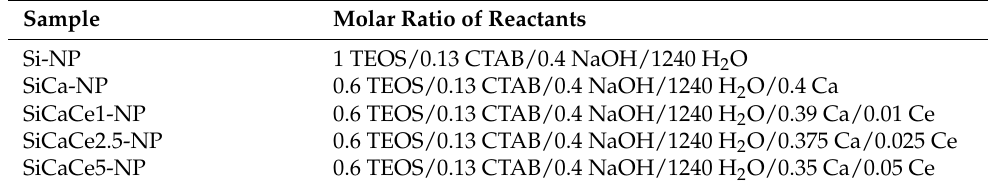
Table 1. Reaction stoichiometry for the produced MSNs.